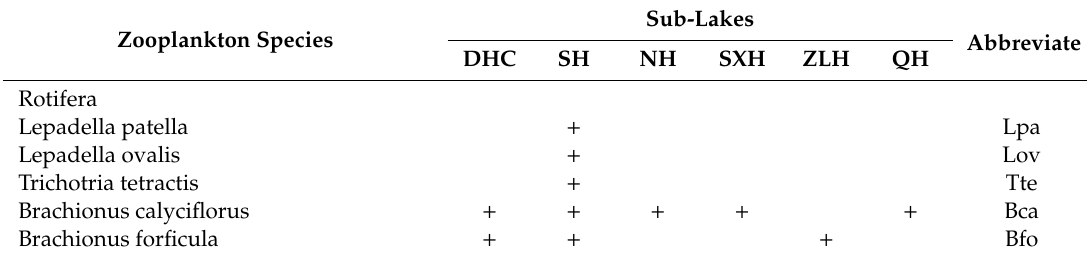
Table A1. Species list of zooplankton in six sampling